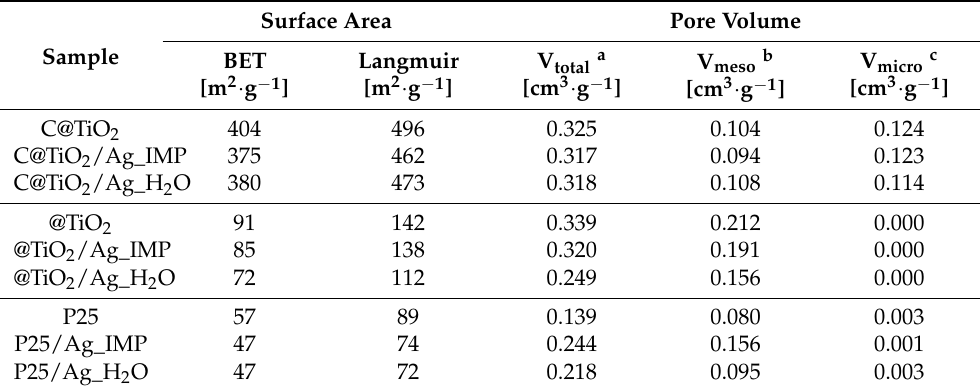
Figure 4. N 2 adsorption-desorption isotherms for C@TiO 2 ( a ), @TiO 2 ( b ) and P25 ( c ) materials before and after deposition of Ag using two different methods—IMP and H 2 O. Table 1. Textural parameters of C@TiO 2 (a), @TiO 2 (b) and P25 (c) materials before and after deposition of Ag using two different methods—IMP and H 2 O.